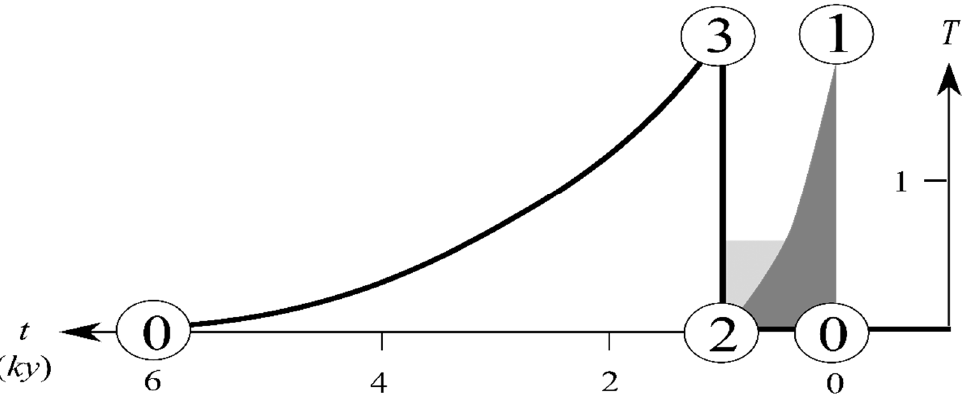
Figure 6. The anatomy in SST (thick solid line) of the H cycle corresponding to that of Figure 5. The light and dark shades symbolize the freshwater flux and sea-ice extent, respectively.